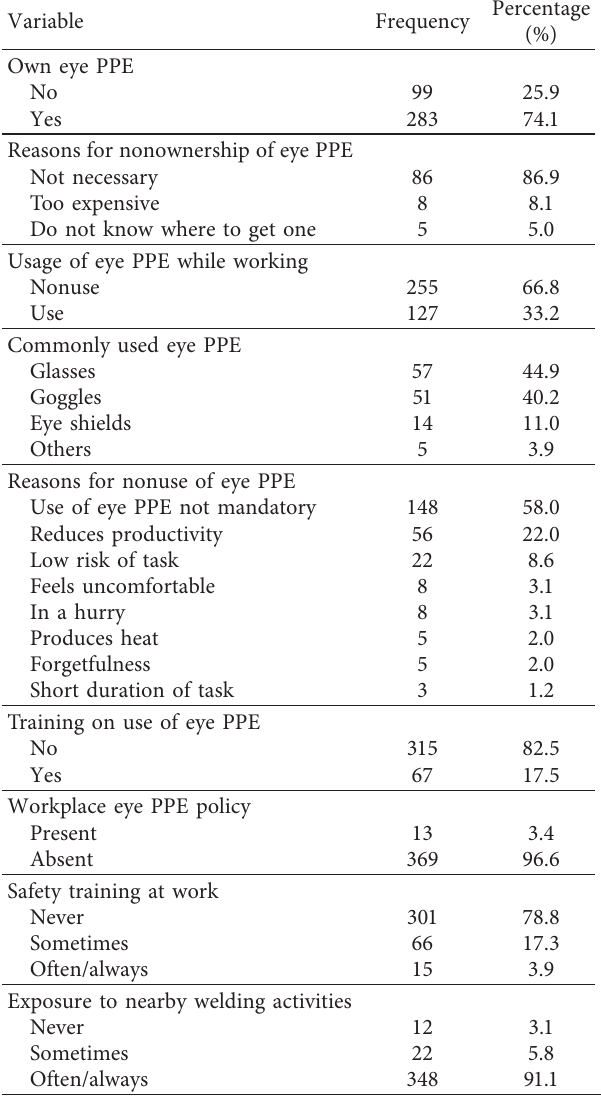
Table 3: Ownership, use of eye PPE, and workplace